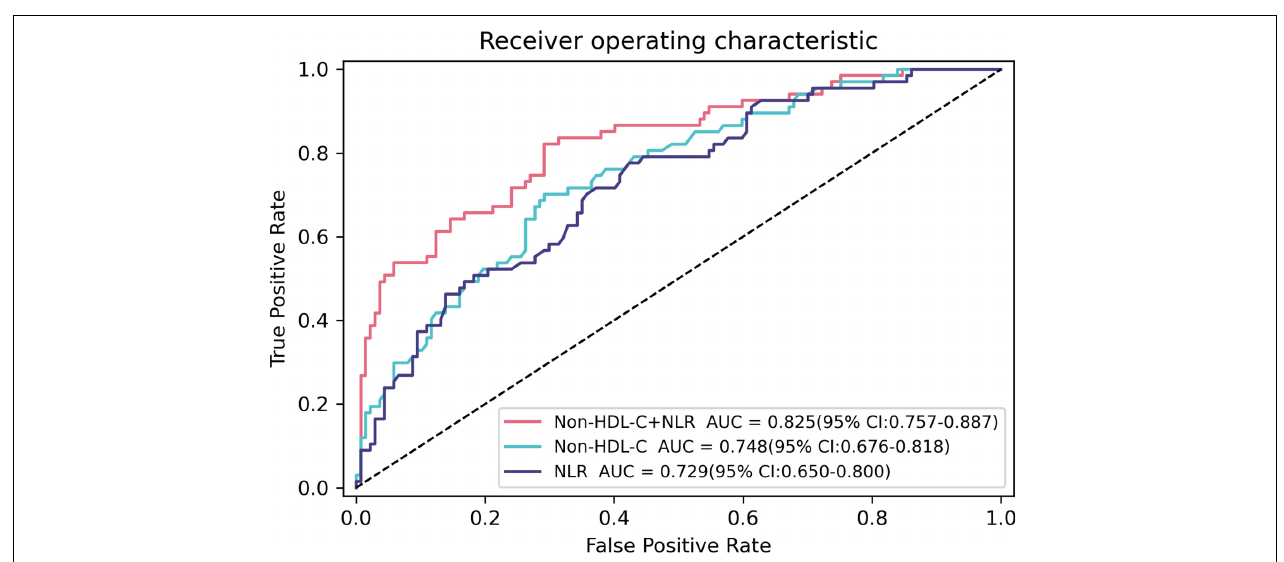
FIGURE 2 | Receiver operating characteristic curves for predicting coronary artery vulnerable plaques using baseline Non-HDL-C, NLR, and their combination in T2DM patients. The AUC of Non-HDL-C, NLR, and their combination were 0.748 (95% CI: 0.676–0.818), 0.729 (95% CI: 0.650–0.800), and 0.825 (95% CI: 0.757–0.887),